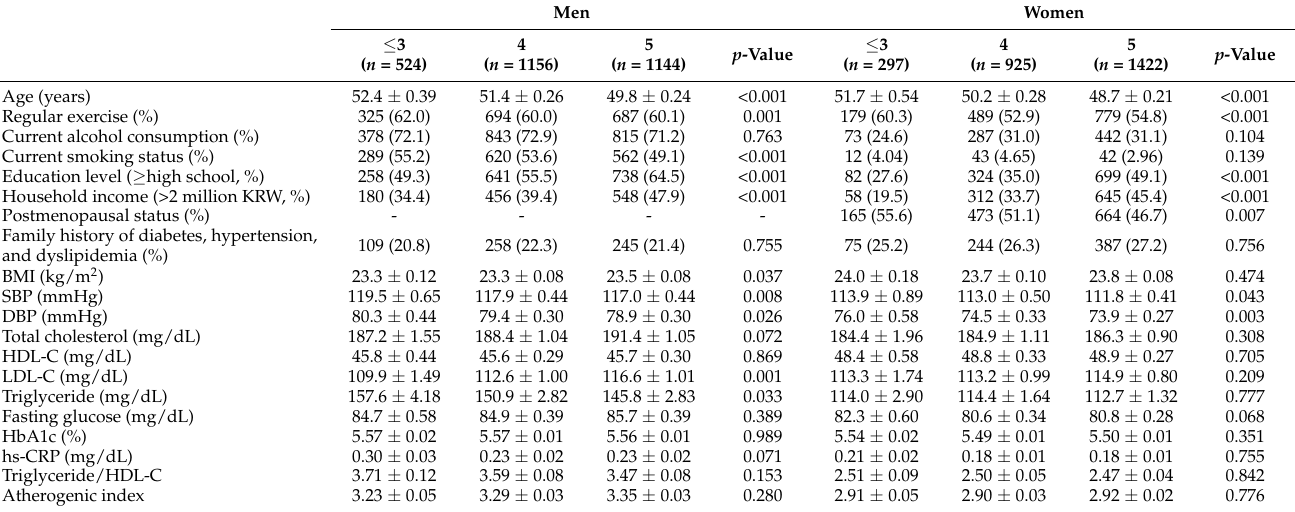
Table 1. Baseline characteristics of participants according to dietary diversity